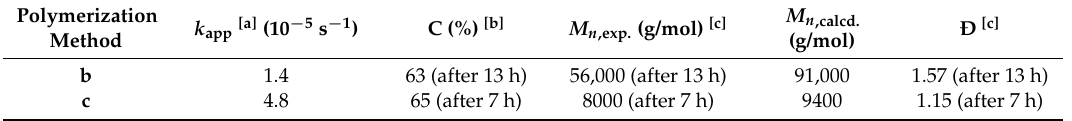
Table 6. Reaction constants for varying polymerization conditions with C2 .